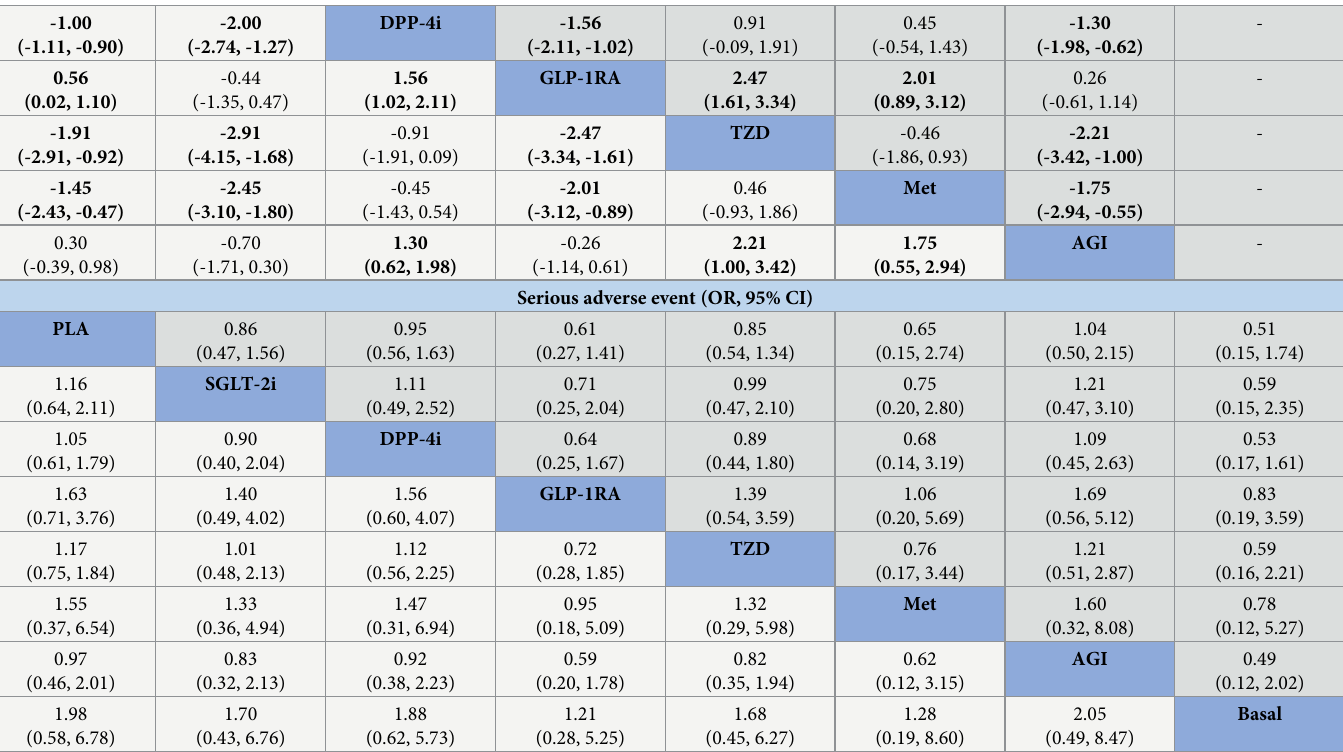
For the lower triangle, comparisons should be read from left to right. Odds ratios (ORs) < 1 favor the column-defining treatment and mean differences (MDs) < 0 favor the column-defining treatment. For the upper triangle, comparisons should be read from right to left. Odds ratios (ORs) < 1 favor the row-defining treatment and mean differences (MDs) < 0 favor the row-defining treatment. Bold fonts indicate statistically significant differences. HbA1c, glycated hemoglobin; SGLT-2i,